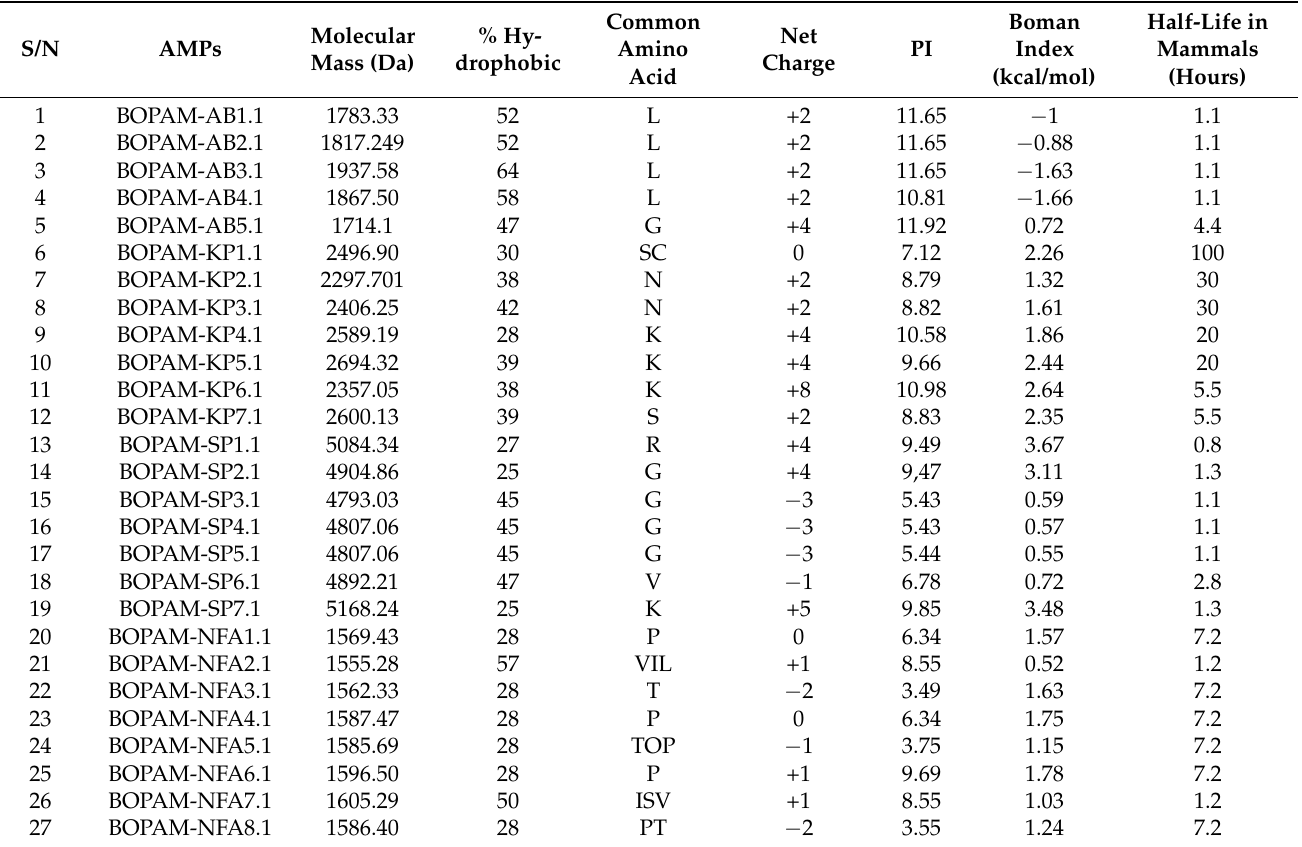
Table 3. Physicochemical properties of the mutated antibacterial and antiviral pneumonia